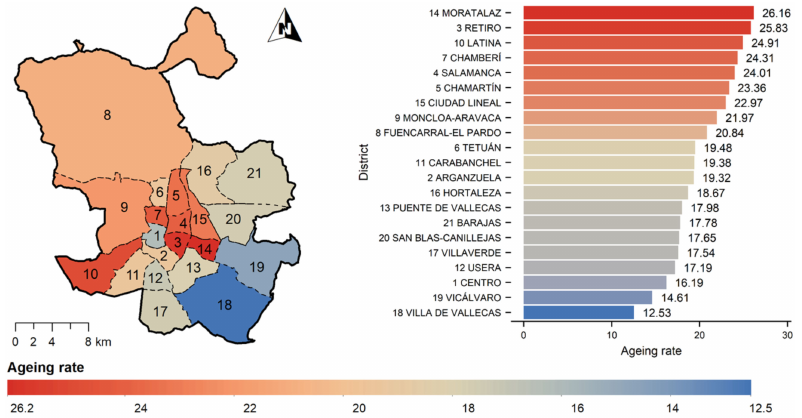
Figure 1. Madrid ageing rates for city districts